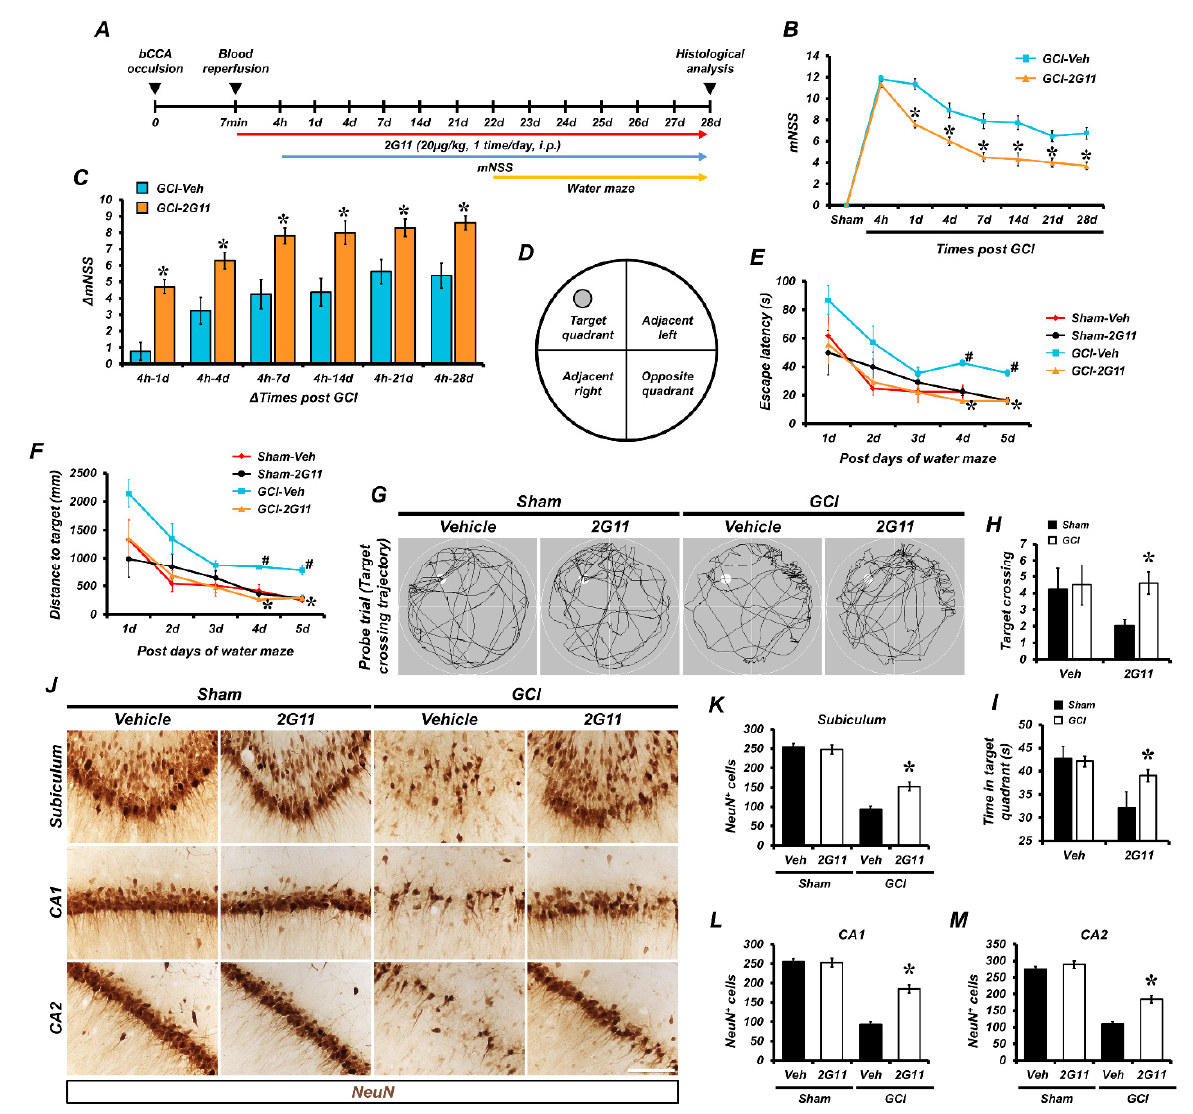
Figure 6. Neurologic impairment and cognitive decline following GCI were protected by 2G11 treatment. ( A ) Timeline displaying the experimental design. 2G11 was intraperitoneally administered once per day for 28 days before animal sacrifice. Rats were then sacrificed 28 days after GCI. ( B ) The mNSS determined in rats at 4 h, 1 day, 4 days, 7 days, 14 days, 21 days, and 28 days after GCI. mNSS score range from 0 to 18. A score of ‘0’ means that all tasks were completed, while a score of ‘18’ means that all tasks were failed. ( C ) Changes in mNSS score ( Δ mNSS) were evaluated at various time intervals between the 4 h time point and the multiple predetermined time points thereafter. Data are the mean ± SEM; n = 7–10. * p < 0.05 vs. the vehicle-treated GCI group. ( D ) Schematic diagram of the tank for MWM performance. ( E , F ) Escape latency and distance to the target of the acquisition trial for five consecutive days starting on post-injury day (PID) 22. Data are the mean ± SEM; n = 7–10. * p < 0.05 vs. the vehicle-treated GCI group; # p < 0.05 vs. the vehicle-treated sham group. ( G ) Representative tracing image of swimming during the MWM probe trial. The target is indicated with a white circle. ( H ) Counts of target crossing during the probe trial. ( I ) Time spent in the target quadrant during the probe trial. Data are the mean ± SEM; n = 7–10. * p < 0.05 vs. the vehicle-treated GCI group (Kruskal–Wallis test followed by a Bonferroni post-hoc test: H: chi square = 25.886, df = 3, p < 0.05; I: chi square = 19.927, df = 3, p < 0.05). ( J ) Representative images show neuronal survival stained with NeuN 4 weeks after GCI. Scale bar = 100 μ m. ( K – M ) The counts of NeuN-positive neurons in the hippocampal subiculum, CA1, and CA2. Data are the mean ± SEM; n = 6. * p < 0.05 vs. the vehicle-treated GCI group (Kruskal–Wallis test followed by a Bonferroni post-